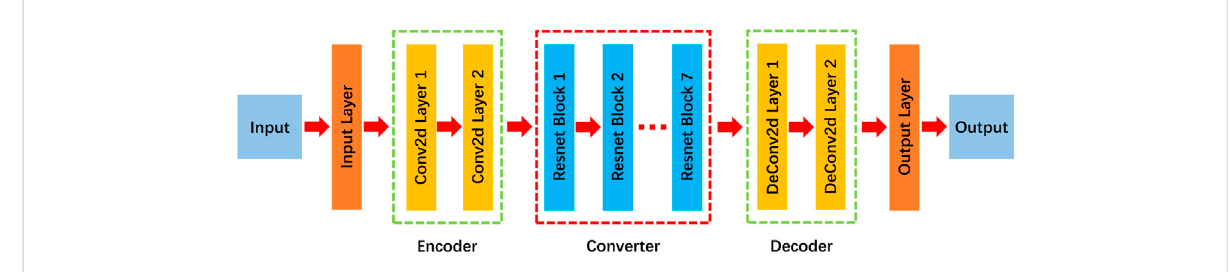
FIGURE 2 The speci fi c structure of the generator, consists of 2 convolutional layers forming the encoder, 7 Resnet blocks as the converter, and 2 deconvolutional layers as the decoder.